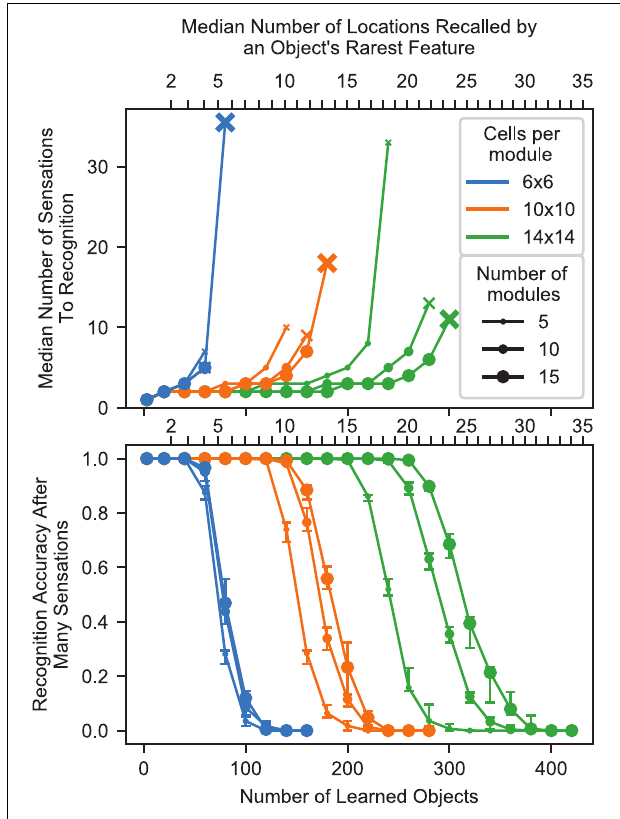
FIGURE 9 | Summary chart showing recognition time and capacity while varying the model parameters. The top chart shows the median number of sensations required to recognize an object, and it marks the final point where a network recognized at least 50% of objects using an ‘x’. The bottom chart shows the percentage of objects that were recognized after traversing every point on the object multiple times. The charts share an x -axis, and this x -axis has two sets of ticks and labels. The bottom ticks are numbers of learned objects, given 10 locations per object and 100 unique features. The top ticks are the typical smallest union sizes that will be invoked by each object. With different statistics, these curves will shift relative to the bottom ticks, but they should stay approximately fixed relative to the top ticks. We repeat the experiment with 10 different sets of random objects. In the top chart, we combine the data from all trials and plot the median. In the bottom chart, we plot the 20th, 50th, and 80th percentiles for each data point across trials.